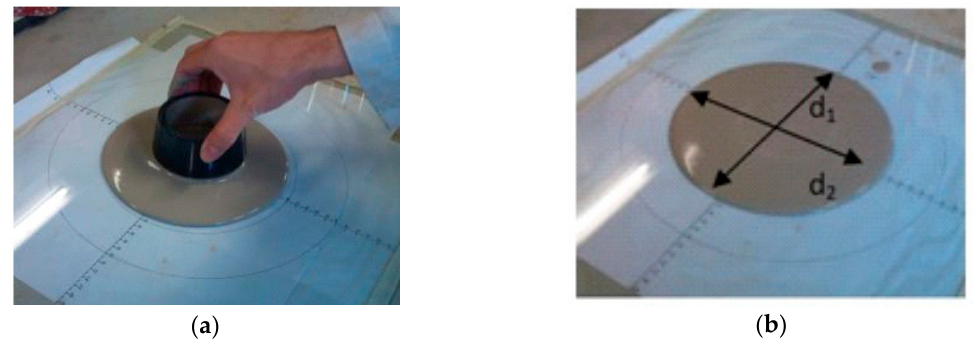
Figure 7. Slump test, ( a ) Lift the cone; ( b ) Spread sample at stoppage.